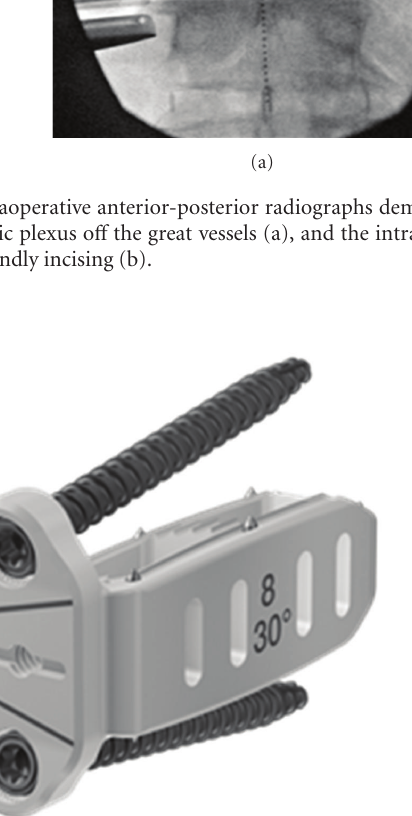
Figure 2: Photograph demonstrating the 30-degree hyperlordotic cage with attached screws to prevent ventral migration into the